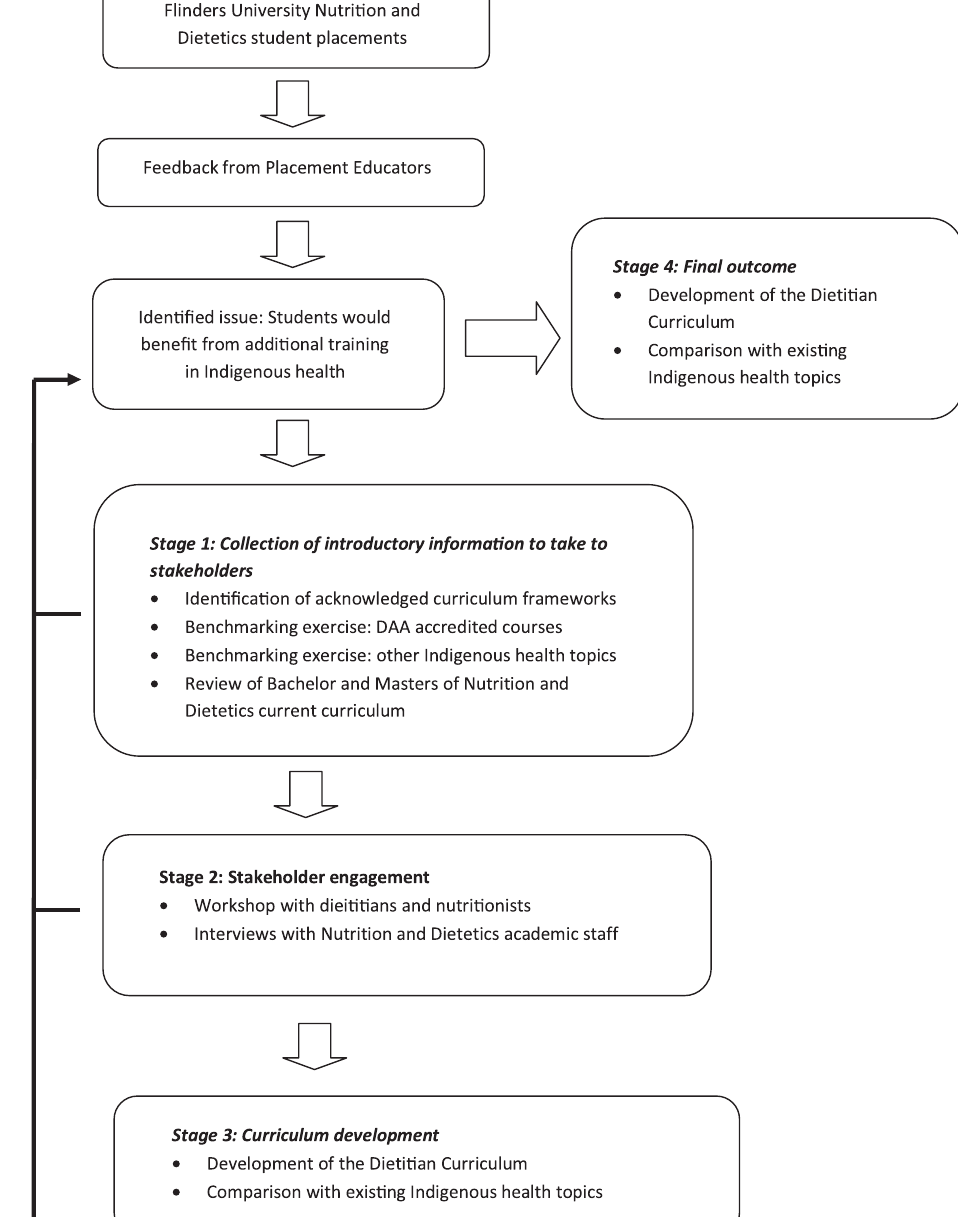
Action research process used to review the Nutrition and Dietetics curriculum identified the issue, local dietitians and nutritionists who had an understanding of the local context, and university academic staff who teach Indigenous health, as well as those who teach BND and MND students. These stake- holders were all willing to be involved in the application of the results, another feature of action research (Denzin & Lincoln, 2011). The cyclical nature of action research, with earlier cycles informing later cycles, enabled us to obtain multiple perspectives on the issue and progress to a final, agreed-upon action. Figure 1 presents the research pro-